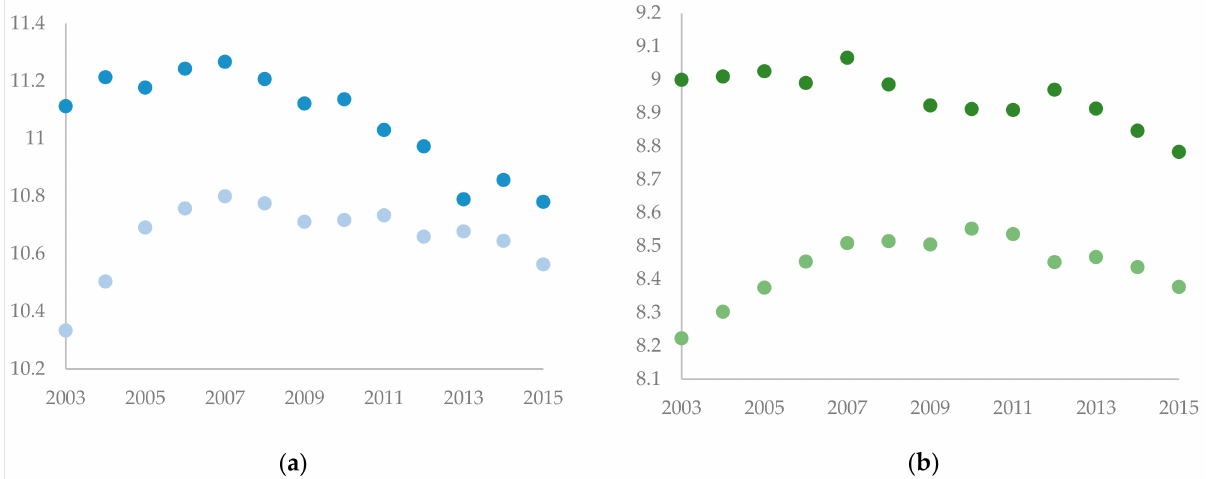
Figure 1. The evolution of the averaged variables. ( a ) shows the year-average ln ( SO 2 ) vs. year. The scatter plot of dark color represents the treatment group, and the scatter plot of light color represents the control group. ( b ) shows the year-average ln ( wastewater ) vs. year. The scatter plot of dark color represents the treatment group, and the scatter plot of light color represents the control group.